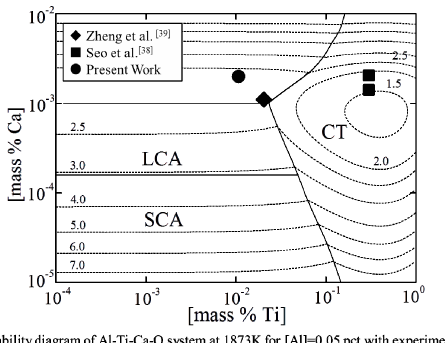
Figure 6. Calculated diagrams of stable oxides in the Al–Ca–Ti–O system at 1873 K ( a ) [Al] = 0, ( b ) [Al] = 0.005%, ( c ) [Al] = 0.05%.